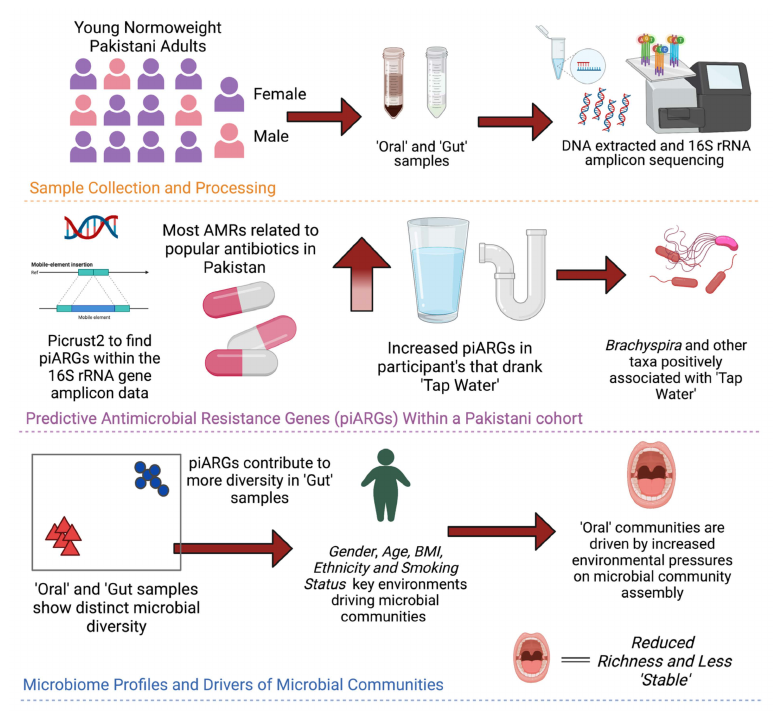
Figure 8. Summary of the key findings of our study. Visualisation was created with